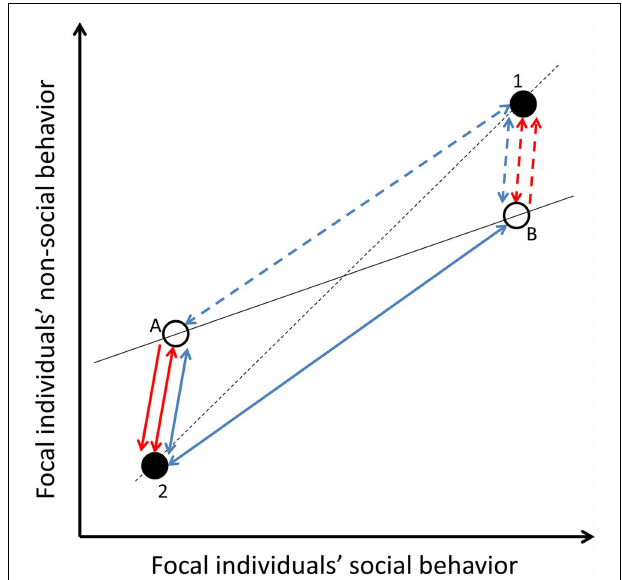
FIGURE 5 | Covariation between focal individuals’ social- and non-social behaviors. Open circles (A and B) represent two different focal individuals, while filled circles represent two different social environments or carry-over effects (1 and 2). If there is no among-individual variation in confronted social environments or carry-over effects (i.e., both focal individuals confront both partners), they explain within-individual level correlation between the behaviors of the focal individuals (two-directional blue arrows: dashed lines for carry-over effects from social environment 1 and solid arrows for carry-over effects from environment 2). The temporal consistency of the carry-over effects depends on the temporal consistency of the state underpinning the carry-over effect. If focal individuals differ in the confronted social environment or carry-over effects (i.e., focal individual A confronts environment 2 and focal individual B environment 1), social carry-overs create among-individual level correlation between the behaviors of the focal individuals (red arrows). If this among-individual correlation is underpinned by temporal environmental effects, it is reversible and thus represents plasticity (two-directional red arrows). However, social carry-over effects can also create true behavioral syndromes via permanent environmental effects (one-directional red arrows: dashed lines for carry-over effects from social environment 1 and solid arrows for carry-over effects from environment 2). Two directional arrows refer to temporary environmental effects (i.e., the reversible nature of the carry-over effect) while one directional arrows refer to permanent environmental effects. For simplicity, the social partner effects for different focal individuals (blue arrows) are assumed to be the same